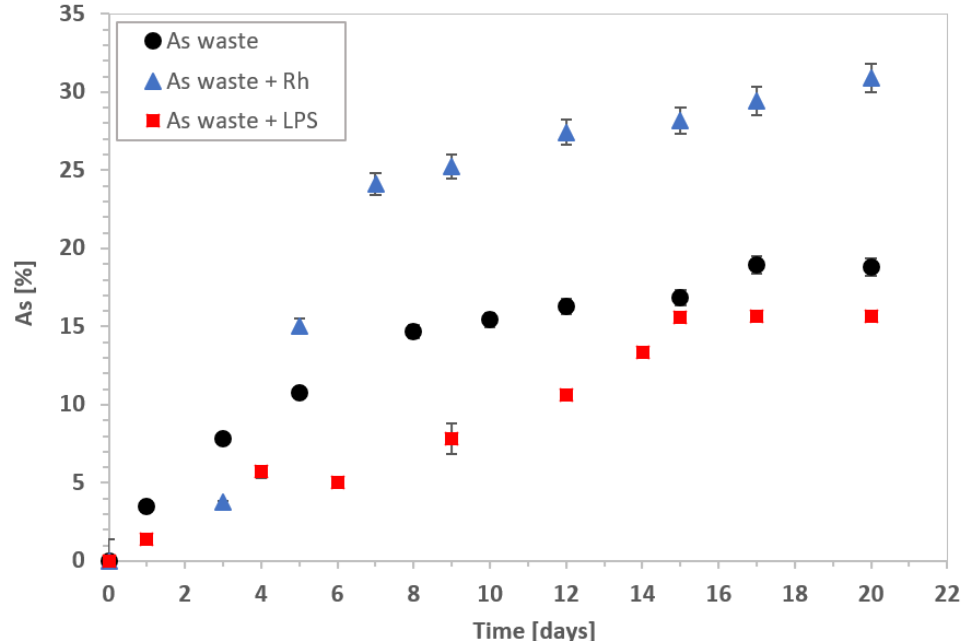
Figure 10. Bioleaching efficiency of As waste without and in the presence of rhamnolipids (Rh) and lipopolysaccharides (LPS).